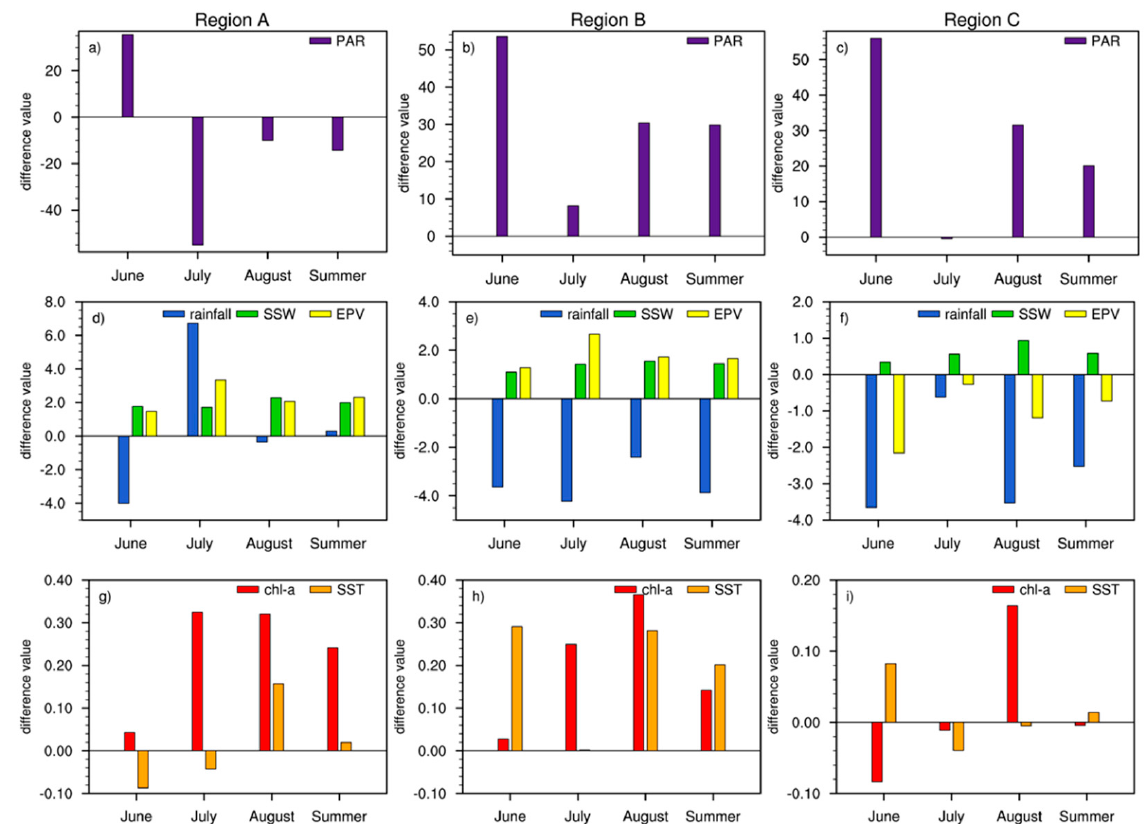
Figure 9. Differences in hydrometeorological variables between LLJ and non-LLJ days in June, July, August, and summer in regions A, B, and C (shown by the black boxes in Figure 4i). PAR in ( a ) region A, ( b ) region B, and ( c ) region C. Rainfall, wind speed (SSW) and Ekman pumping (EPV) in ( d ) region A, ( e ) region B, and ( f ) region C. Chl-a and SST in ( g ) region A, ( h ) region B, and ( i ) region C.